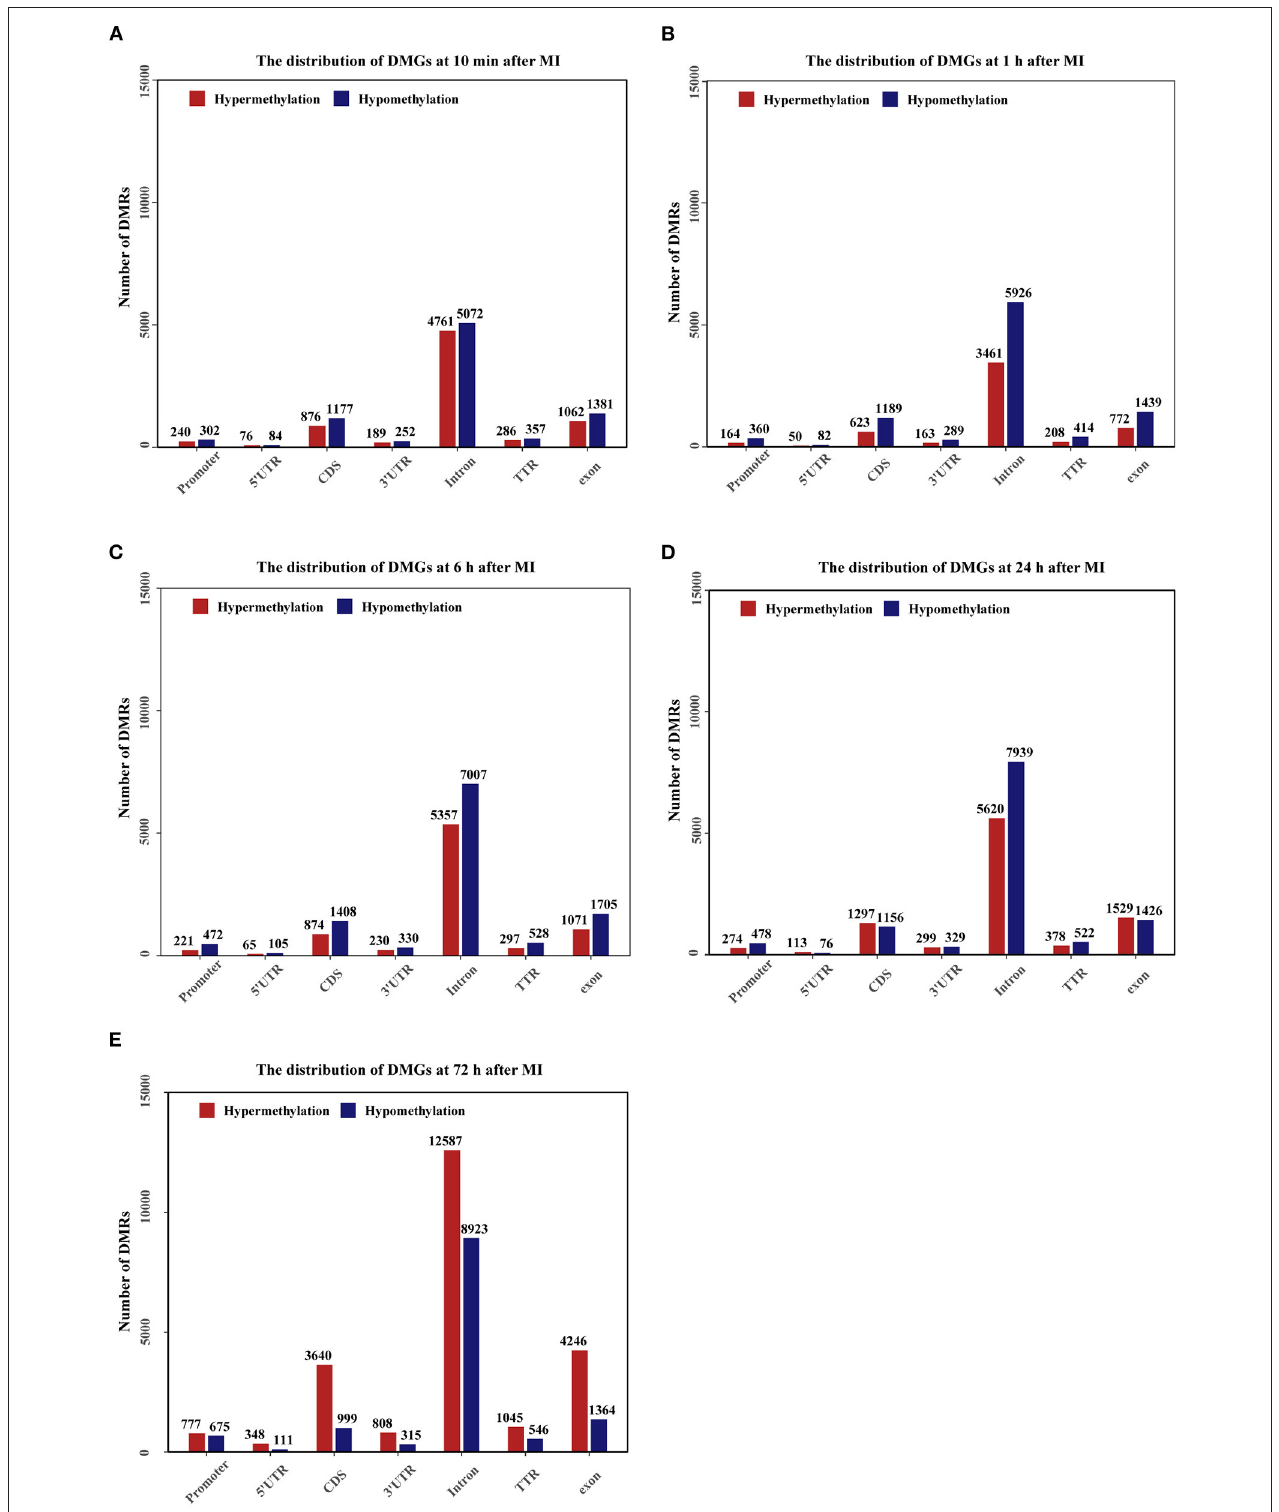
FIGURE 7 | Bar plots showing the numbers of DMGs in promoter (2000bp upstream of the transcription start site), 5’UTR, CDS, 3’UTR, Intron, TTR (5000bp downstream of the transcription termination site), exon regions. The number of DMRs is given at the top of each graph bar. (A–E) The bar plots of DMGs distribution at 10min, 1, 6, 24, and 72h after